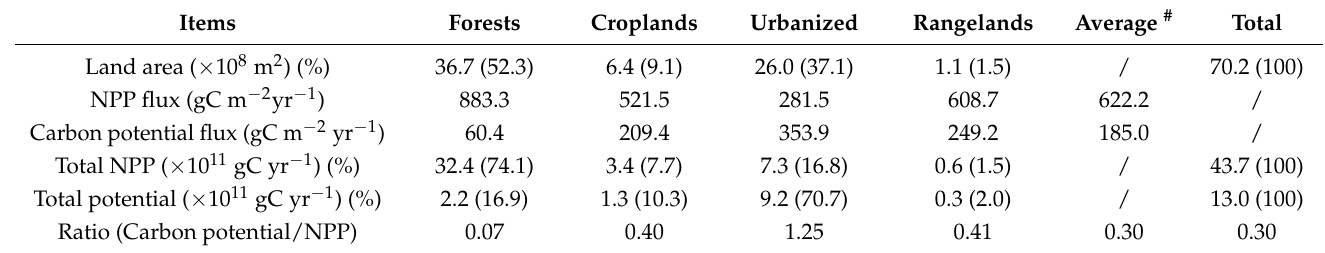
Table 3. Contribution of carbon potential in different land (vegetation) cover classes in